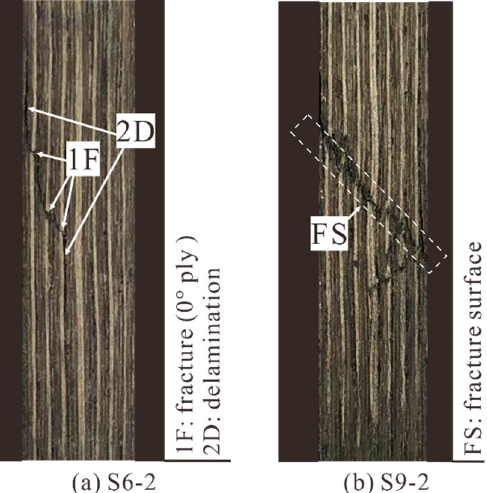
Figure 16. Compression failure modes of specimens (observed from the side), ( a ) with medium crack and ( b ) deep cracks.